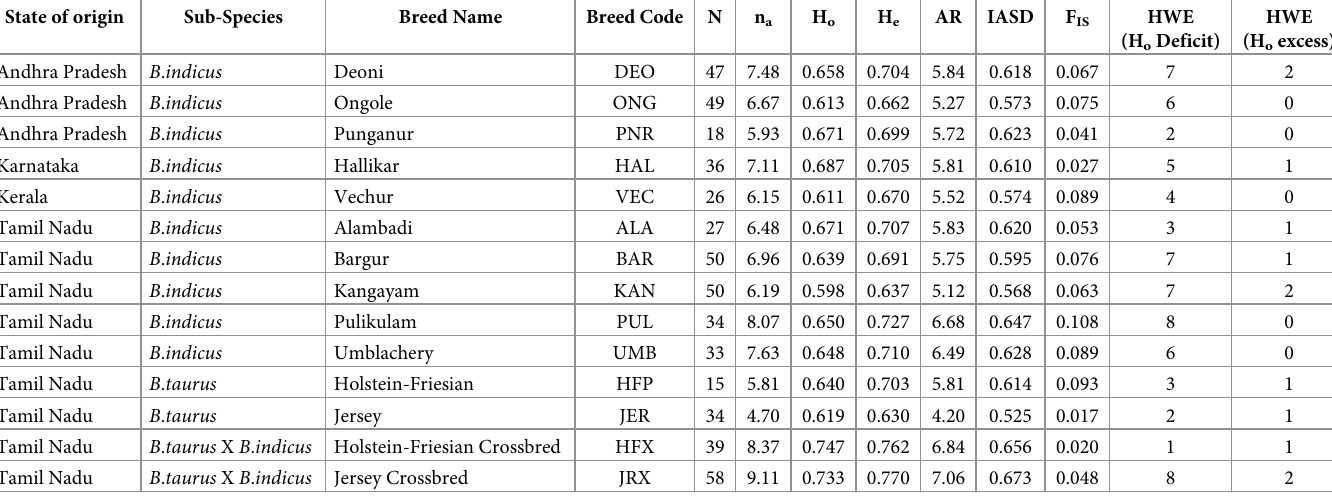
Table 1. Summary diversity statistics for draught type zebu, taurine and crossbred cattle of South India. State of